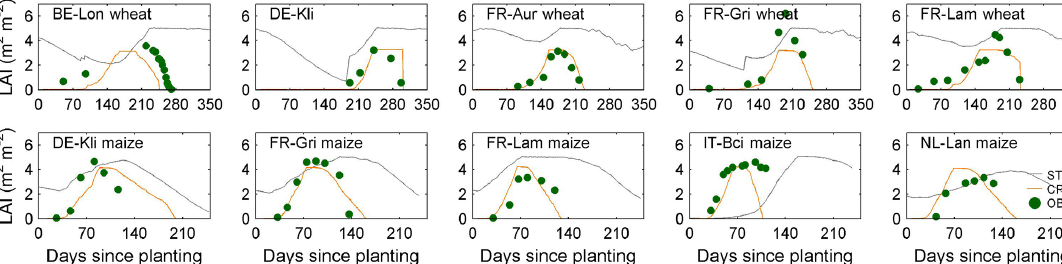
Figure 2. Temporal changes of daily leaf area index (LAI) since planting from observations (green dots), standard ORCHIDEE (ORC-ST0, grey line) and ORCHIDEE-CROP (ORC-CP1, orange line). The upper and lower panel shows the results for different sites of winter wheat and maize,